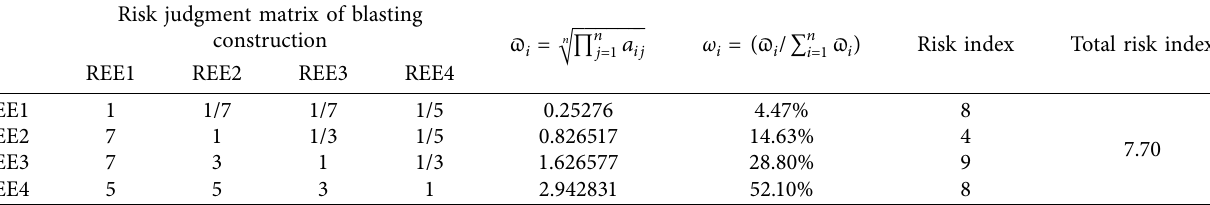
Table 23: Risk judgment matrix of drilling and blasting